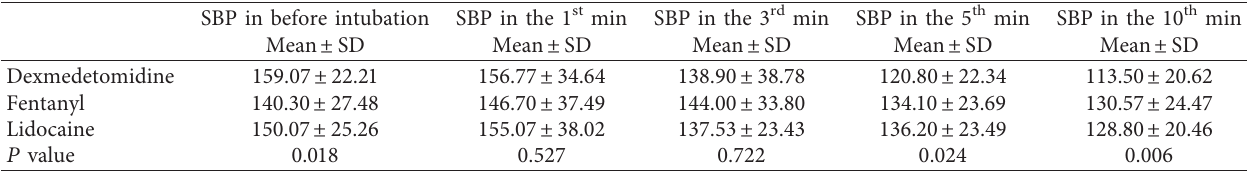
Table 3: Comparison of systolic blood pressure in three groups in the 1st, 3rd, 5th, 10th minutes after intubation with before intubation (meaningful level P < 0 .